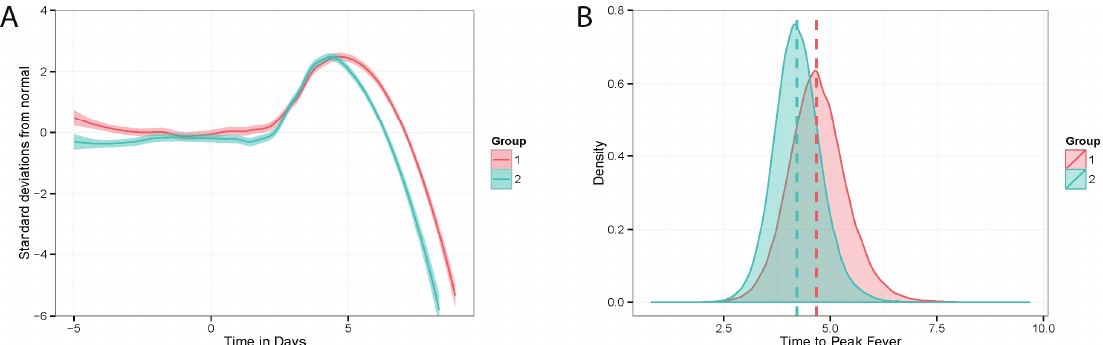
Figure 3. Fever among naïve animals implanted with radio-telemetry devices. ( A ) LOESS curve representing the estimate of average normalized values across each treatment group (Group 1 = 8U red ( n = 8); Group 2 = 7U blue ( n = 8)); ( B ) Posterior predictive distributions of peak fever times across treatment groups (Group 1 = 8U red ( n = 8); Group 2 = 7U blue ( n = 8)).